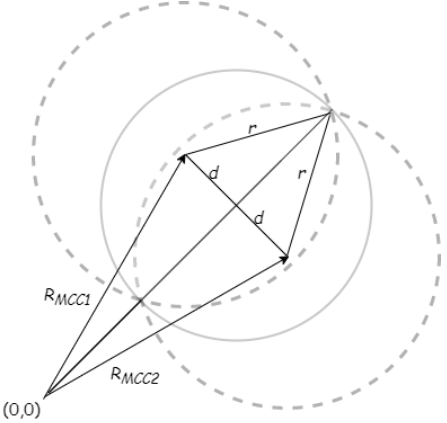
Figure 4. Illustration of the proof of Theorem